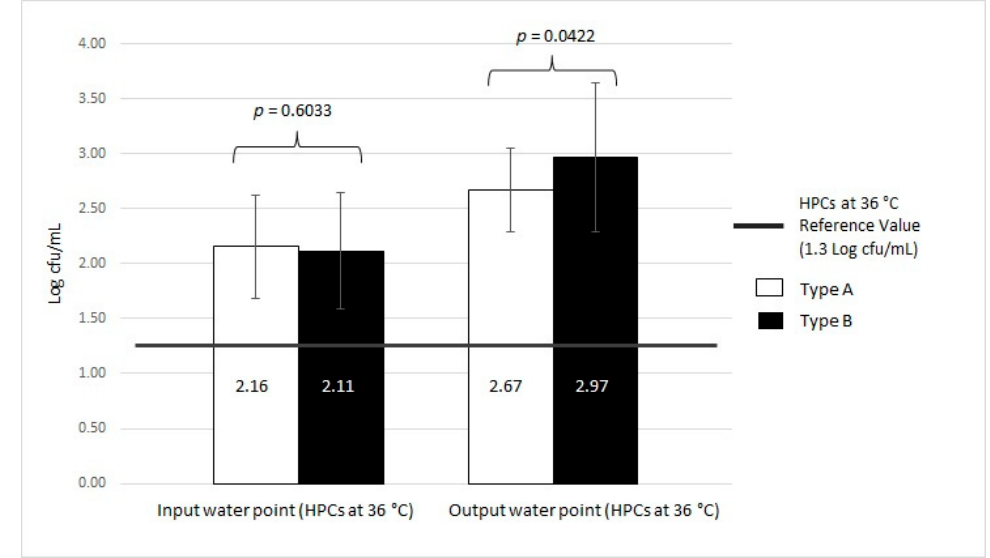
Figure 8. Microbiological contamination in Type A and Type B input vs. output samples using HPC analysis at 36 °C.